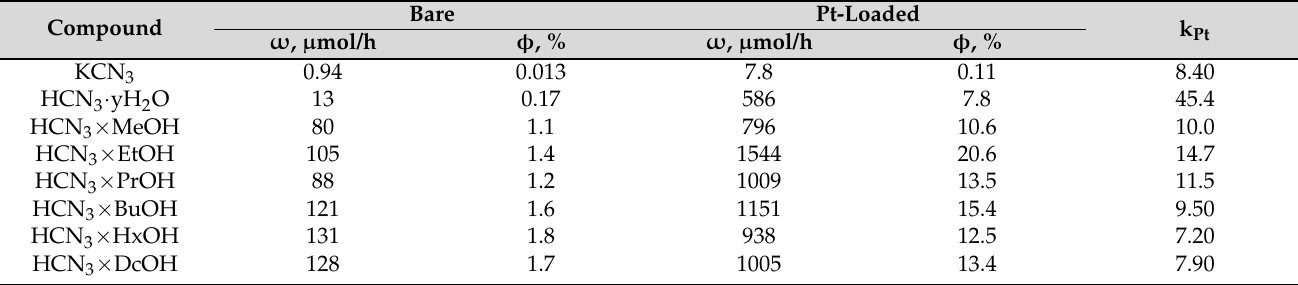
Figure 8. Kinetic curves of photocatalytic hydrogen generation over initial niobates and their n -alkoxy derivatives with a Pt cocatalyst. Table 2. Data on photocatalytic activity of the initial niobates and their n -alkoxy derivatives (hydrogen evolution rate ω , apparent quantum efficiency φ , and platinization increase factor k Pt